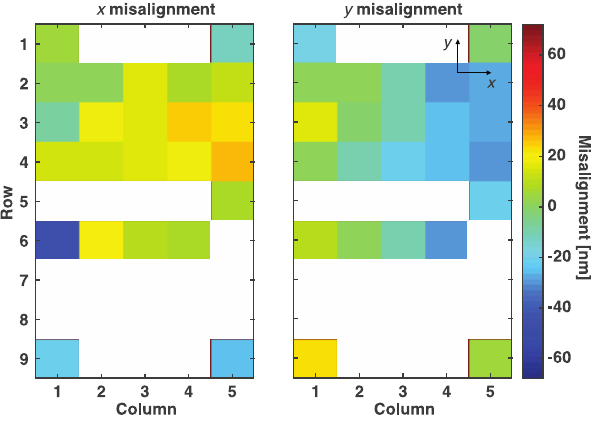
FIG. 8. QD- L 3 PC cavity alignment accuracy. The x - and y - misalignment errors measured for the corner devices of several square arrays.